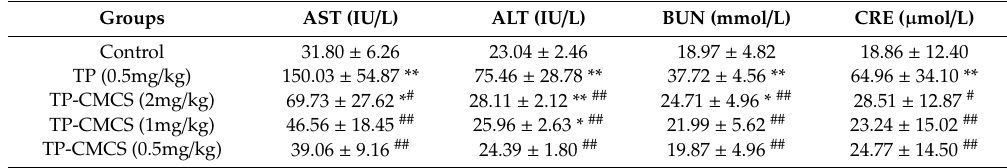
Table 2. Biochemical parameters of TP-CMCS and TP-treated animals ( x ± s, n = 8). Groups AST (IU / L)